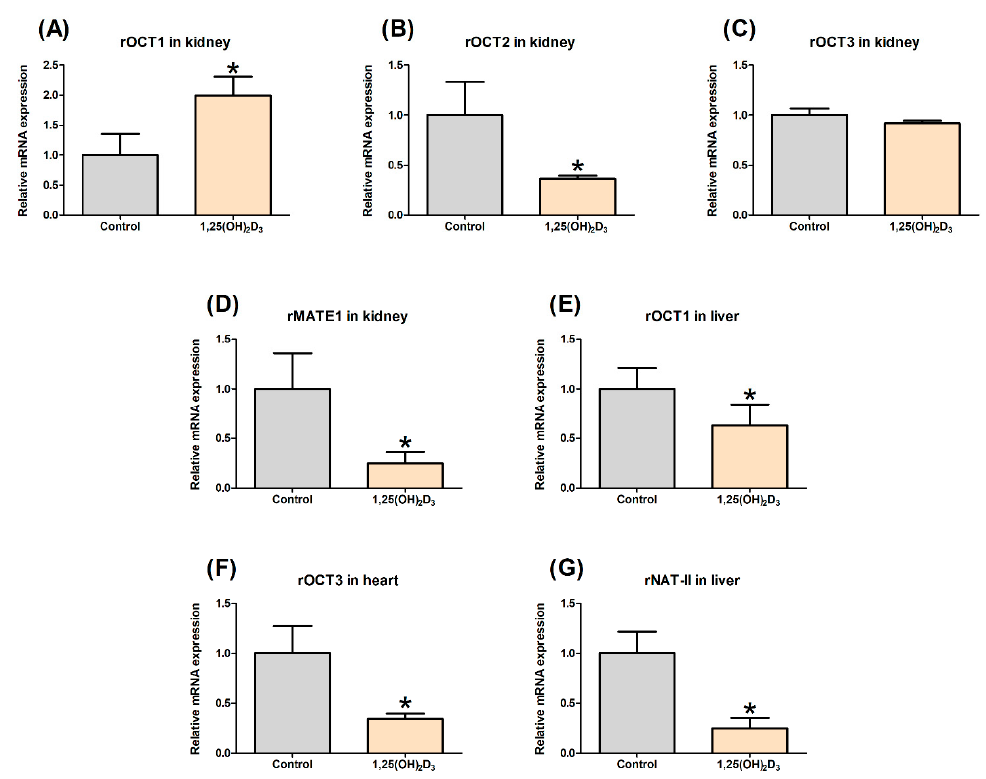
Figure 1. Effects of 1,25(OH) 2 D 3 on the mRNA expression levels of ( A ) renal rOCT1, ( B ) renal rOCT2, ( C ) renal rOCT3, ( D ) renal rMATE1, ( E ) hepatic rOCT1, ( F ) rOCT3 in heart, and ( G ) rNAT-II in liver tissue from control (gray color) and 1,25(OH) 2 D 3 -treated rats (light orange color). * Indicates p < 0.05.